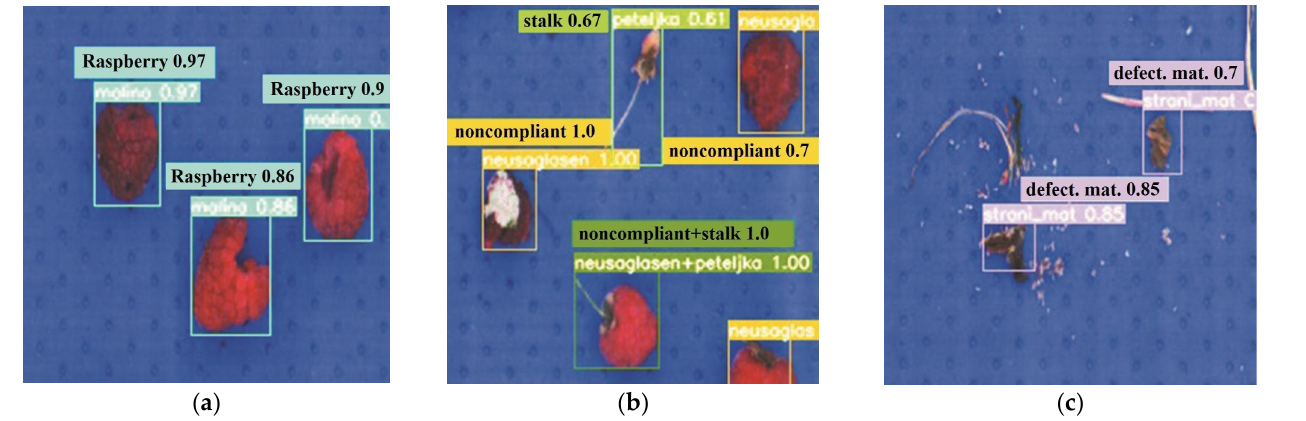
Figure 8. Example of the results obtained in training 3: ( a ) compliant raspberry, ( b ) class of non- compliant raspberry and stalk, ( c ) defective material.